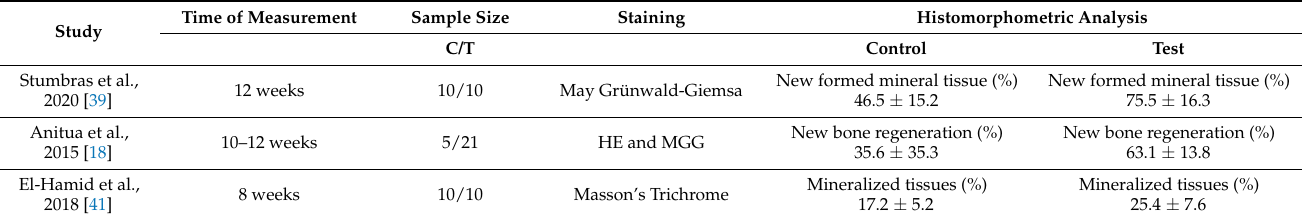
Table 2. Histomorphometric analysis of the included studies.